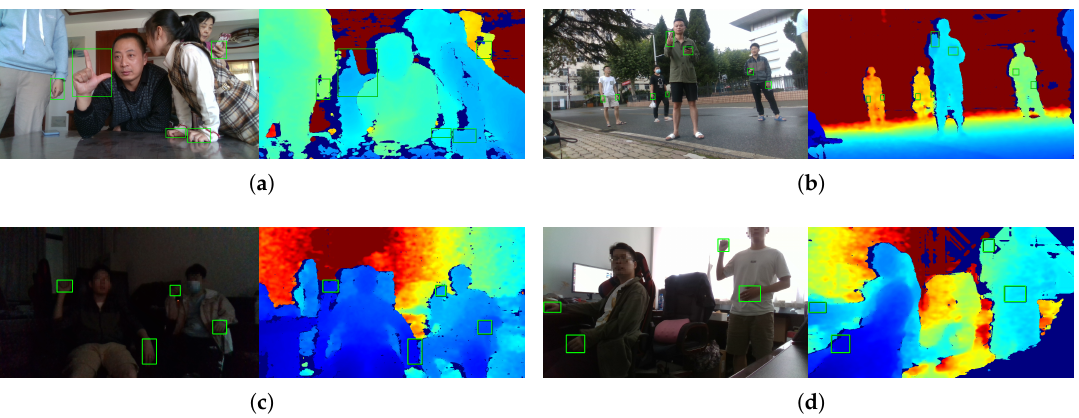
Figure 2. Examples of RGB-D images in our dataset. The RGB-D images are captured in various environments. For each sub-figure, on the left is the RGB channels, and on the right is the corresponding D channel. The indoor scene is shown in ( a ), and the outdoor scene is shown in ( b ). As can be seen in ( c ), the RGB channels can be significantly affected in dark conditions, while the D channel is robust. In ( d ), failure regions appear (around the upholding hand on the right) in the D channel in back-light